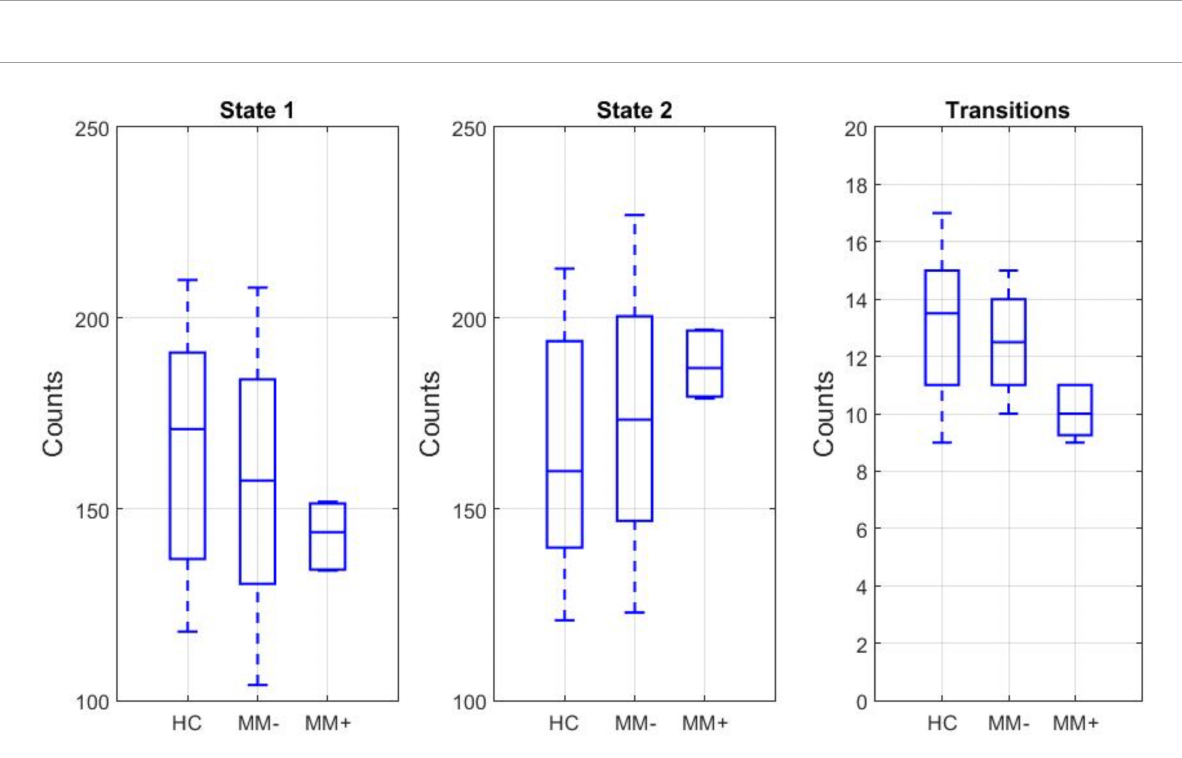
FIGURE4 Left and middle: box plots of the frequency of occurrence in the state 1 and state 2 for each experimental group. Right: box plot of the frequency of state transitions between the two